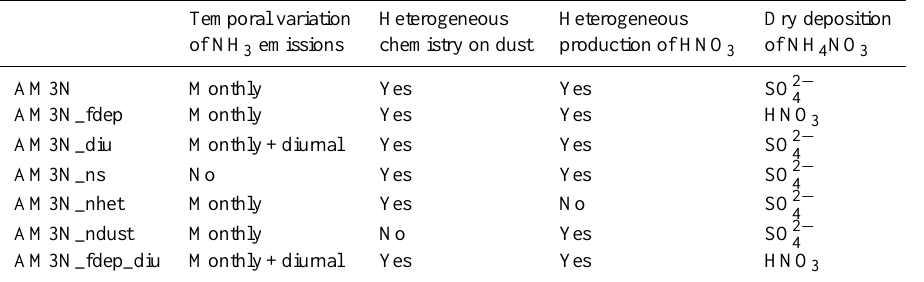
Table 2. Configurations of AM3N used in this study. Temporal variation Heterogeneous Heterogeneous Dry deposition of NH 3 emissions chemistry on